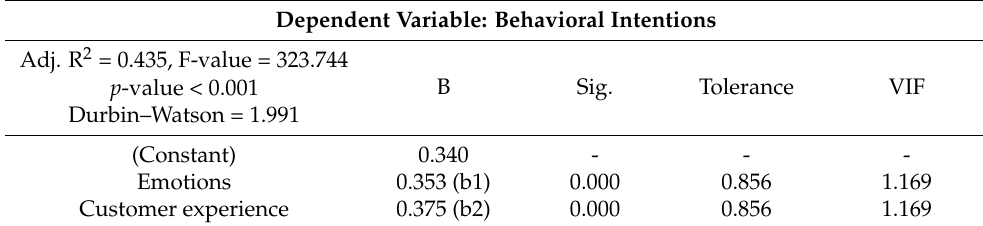
Table 8. Step 4. The multiple regression equation of the mediation